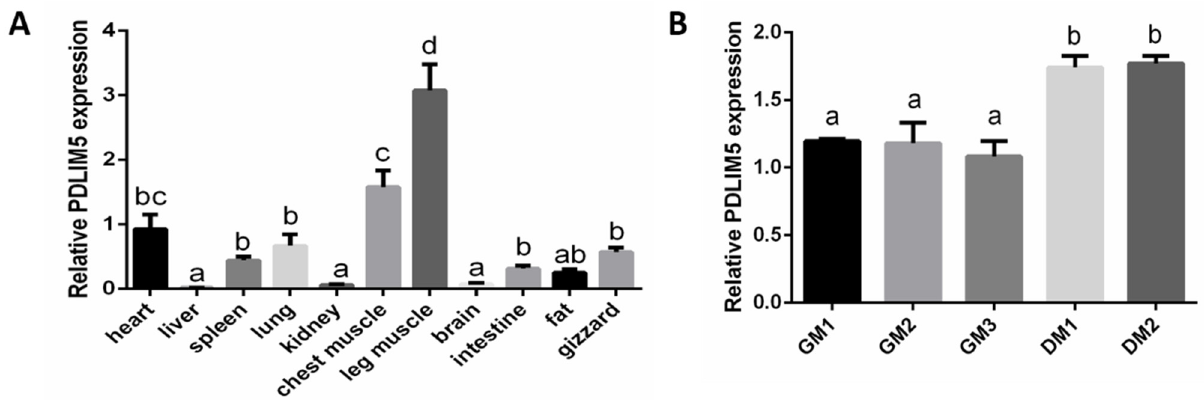
Figure 1. The expression of PDZ and LIM domain 5 (PDLIM5) in different chicken tissues and chicken skeletal muscle satellite cells (SMSCs). ( A ) The expression of PDLIM5 in 11 different chicken tissues determined by qPCR (heart as the control group, n = 9). ( B ) The expression of PDLIM5 in chicken SMSCs at different time points determined by qPCR ( n = 3). a,b,c,d p < 0.05.